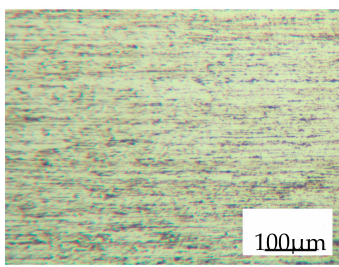
Figure 6. Longitudinal-sectional microstructure of the 1.2 mm Al-5Mg-0.12Zr wire